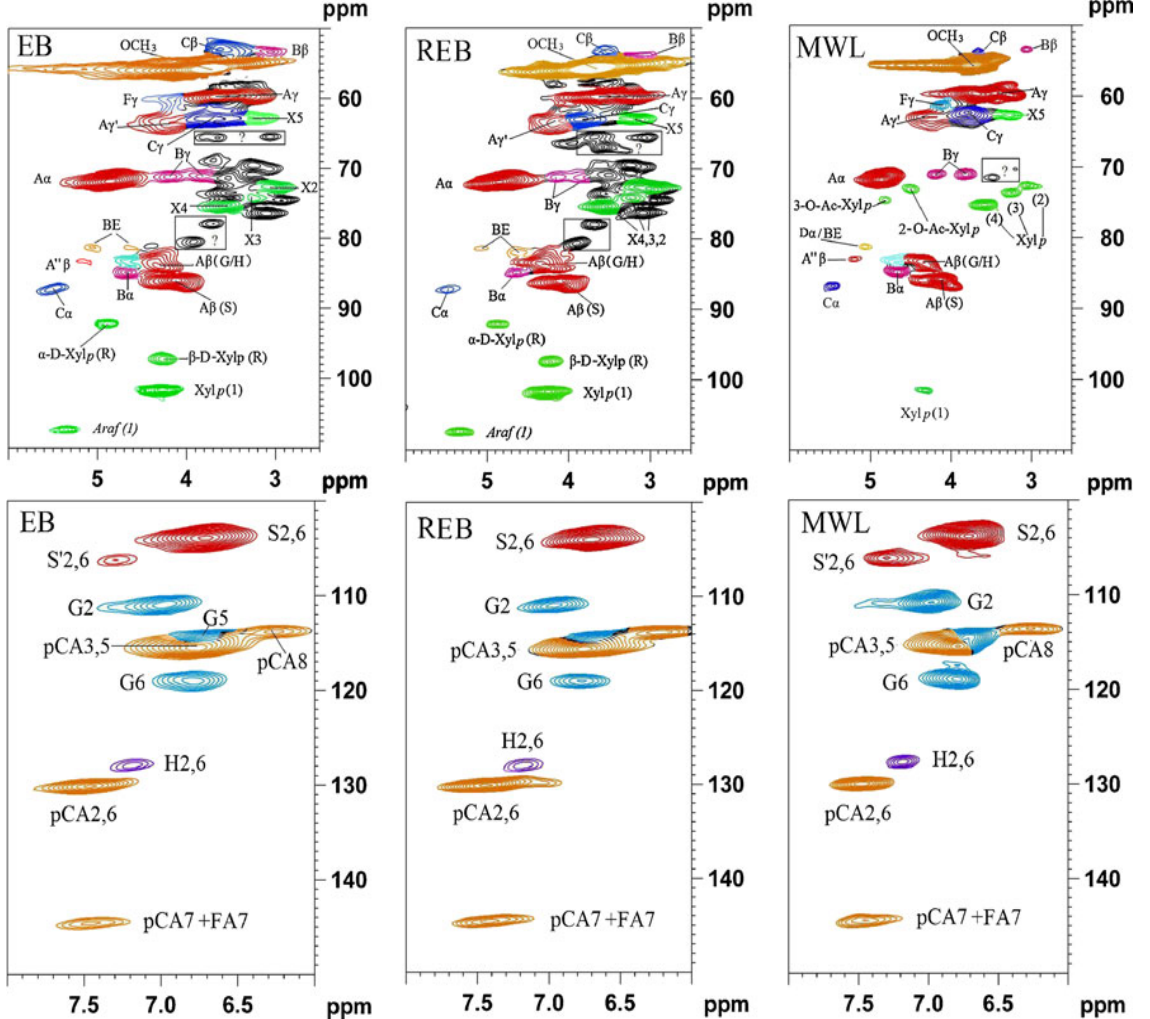
Figure 13. HSQC spectra of non-acetylated EB, REB, and MWL (directly dissolved in DMSO- d , EB, bamboo having undergone enzymatic hydrolysis; REB, regenerated 6 bamboo having undergone enzymatic hydrolysis; MWL, milled wood lignin from bamboo) (Reprinted from [65]. Copyright 2012